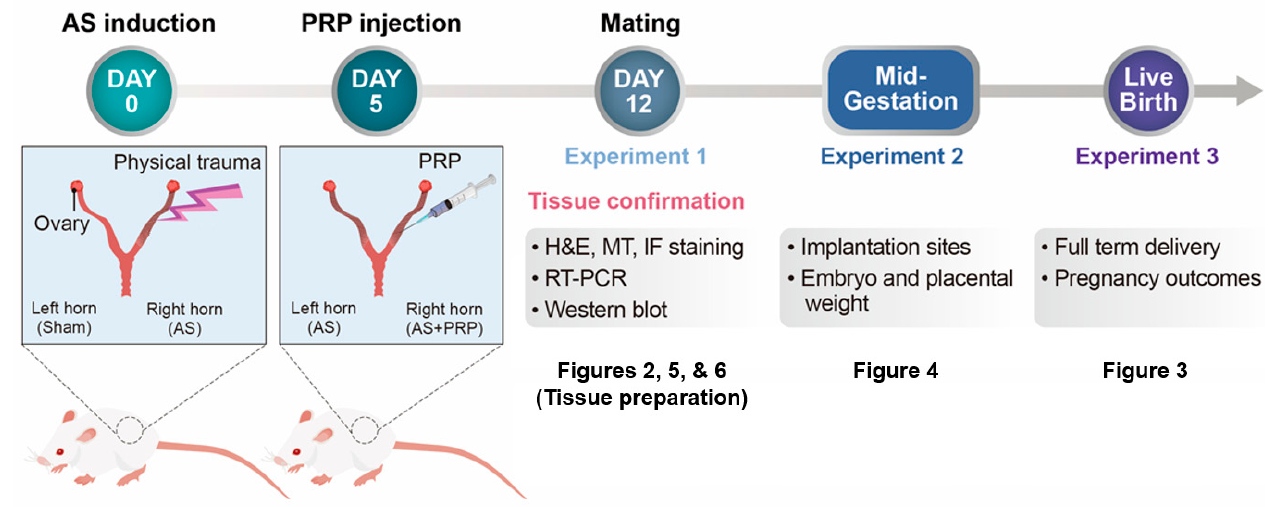
Figure 1. A schematic time-line to show the procedures of experiments performed in this study. Three independent experiments were performed in a mouse model of human Asherman’s syndrome (AS) to evaluate therapeutic effects of hPRP on the injured endometrium. Uterine tissues were prepared 12 days after AS was induced by physical insults (5 days after PRP treatment) for Figures 2, 5, and 6. Mice with AS were housed with fertile males to evaluate reproductive cycle in these mice and pregnant mice were separately maintained until live pups were delivered in Figure 3. Lastly, embryo implantation and post-implantation embryo development in mice with AS were observed on days 5 and 12 of pregnancy.